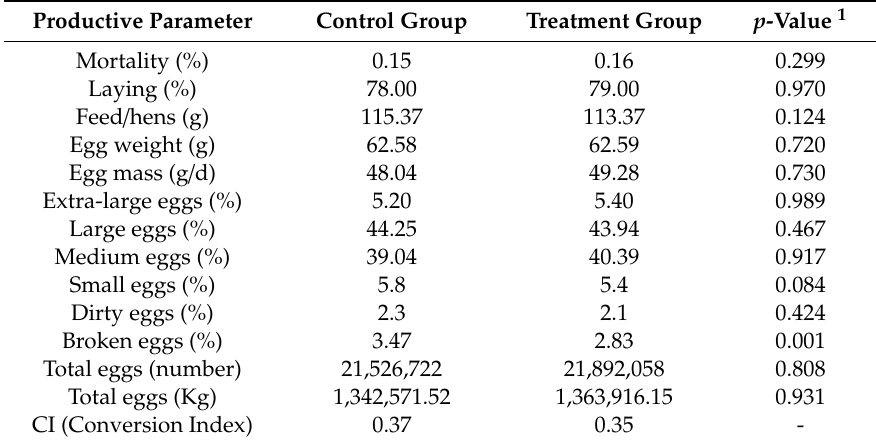
Table 2. Production performance of control and FDA-supplemented hens.